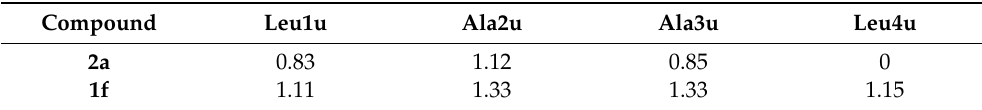
Table 1. 1 H NMR diastereotopicity ( ∆ d) values for main chain methylene protons for compounds 2a and 1f (the ∆ d values are given in ppm).